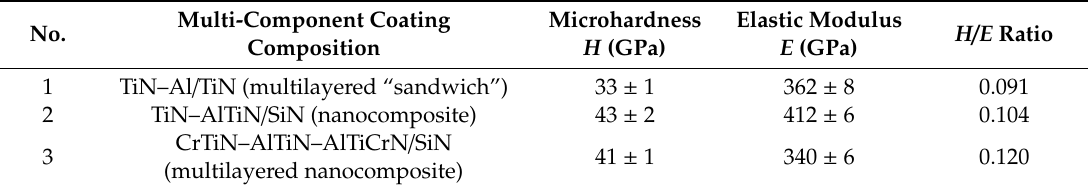
Table 2. Physical and mechanical properties of cathodic arc deposited multi-component coatings.